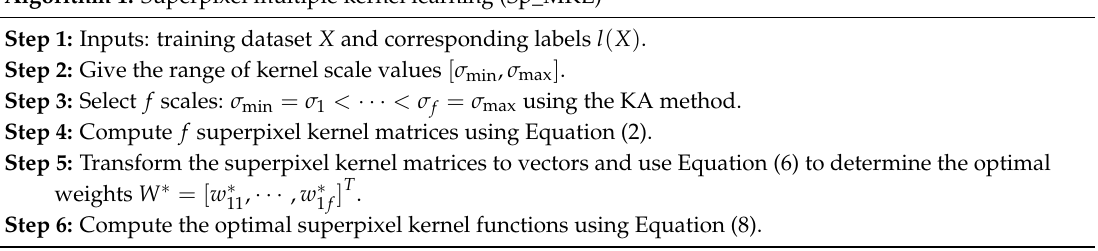
Algorithm 1. Superpixel multiple kernel learning